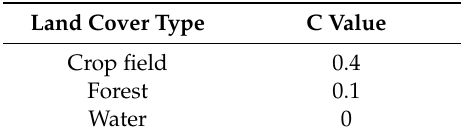
Table 3. Land cover and management factor C [26].